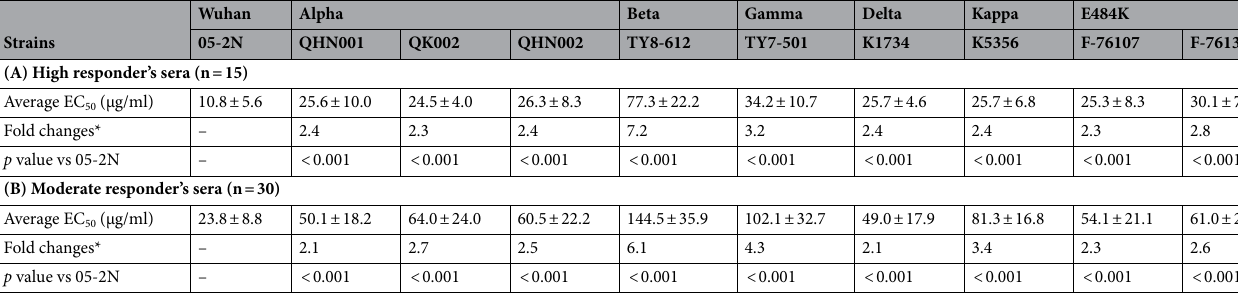
Table 3. Anti-SARS-CoV-2 activity and fold changes of IgG fractions eluted from day-60 sera against VOCs and VUM compared to those against wild-type Wuhan strain. Average EC 50 values of IgG fraction eluted from day-60 sera of high (n = 15) or moderate (n = 30) responders against SARS-CoV-2 05-2N and various variants are indicated. *Fold change of EC 50 values compared to that against SARS-CoV-2 05-2N